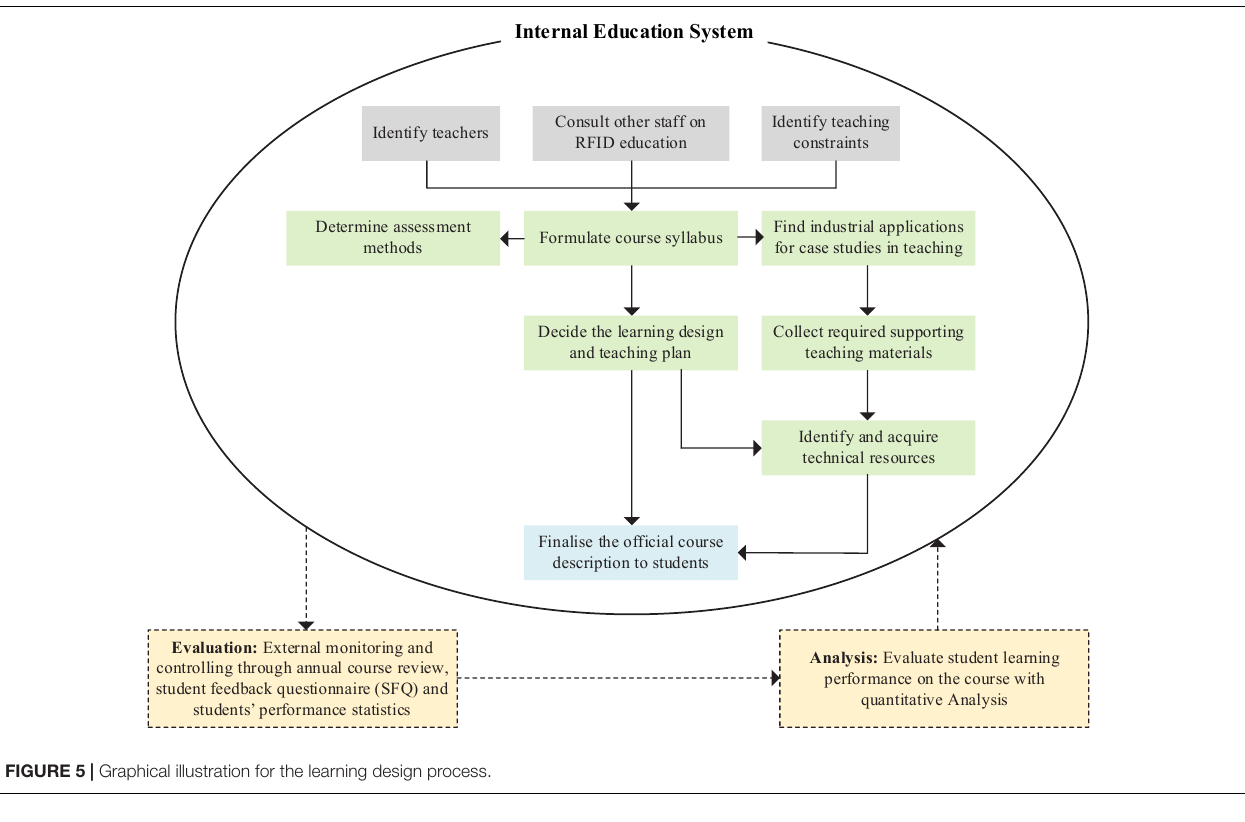
FIGURE 5 | Graphical illustration for the learning design process.